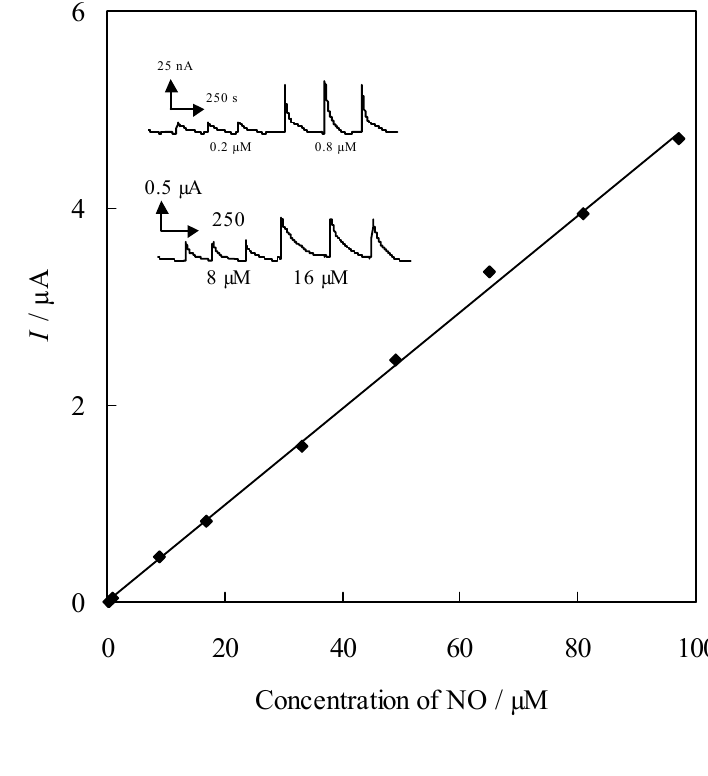
Figure 4. Calibration curve for amperometric determination of NO at a FePyDP modified PGE. Applied potential, -700 mV vs. (Ag|AgCl). Inset: amperometric response upon injection of NO